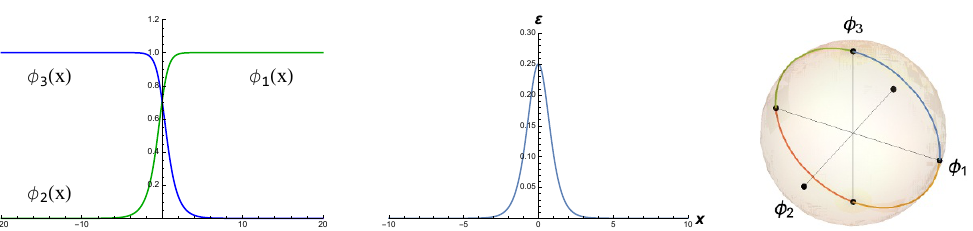
Figure 3 . Pro(cid:12)le of the Cartesian (cid:12)eld components (left), wall tension density (middle) and orbits for the K ( q;a;c ) ( x ) domain walls 2